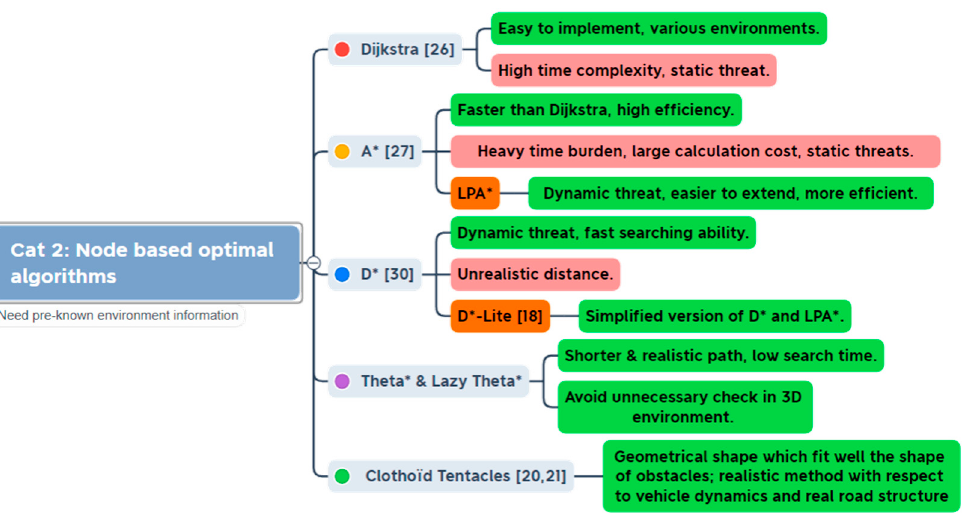
Figure 4. Node-based optimal approaches with the main advantages and drawbacks.